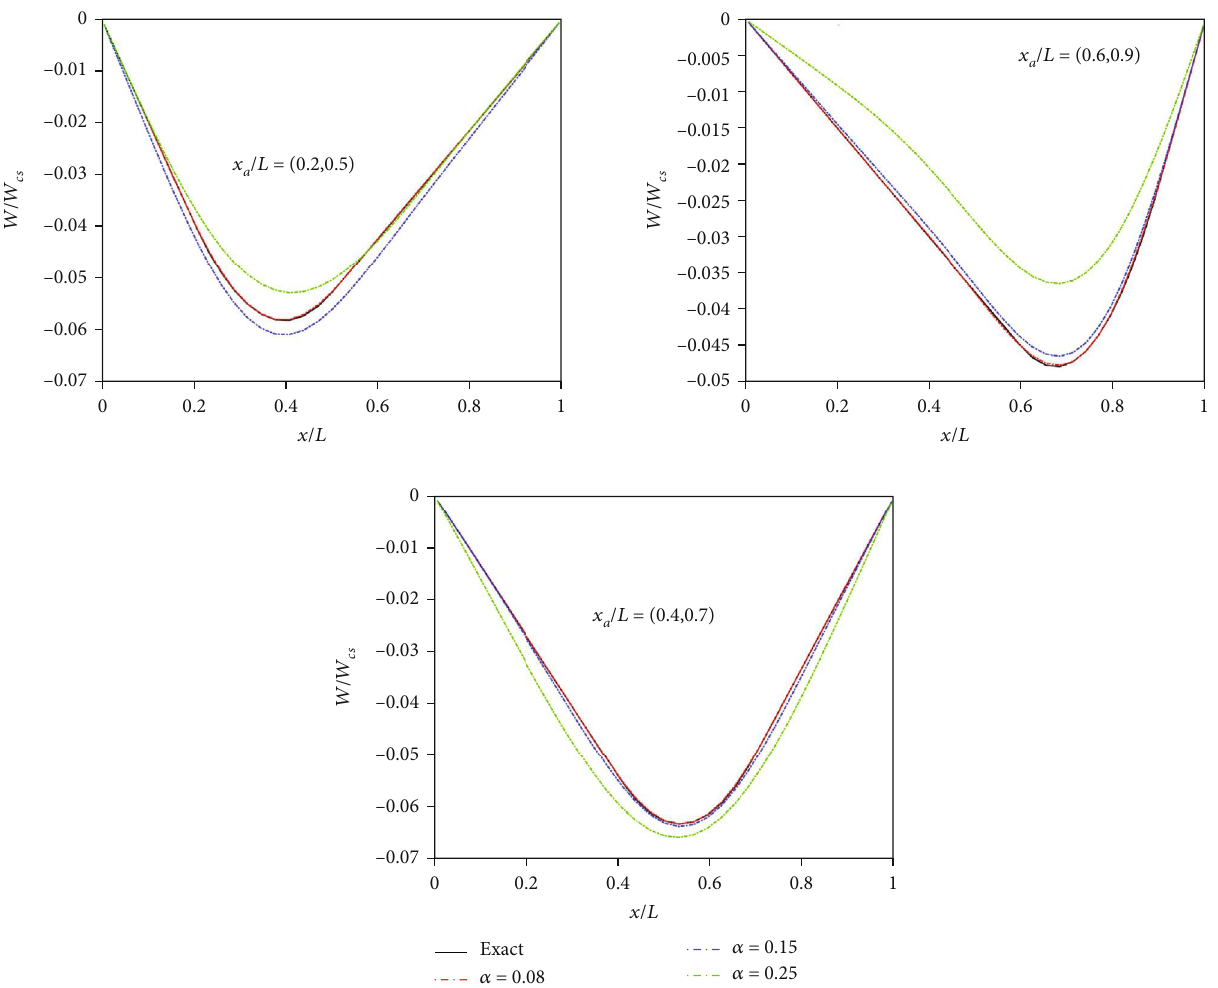
Figure 5: Convergence and accuracy of the numerical results with decreasing α of the dimensional de fl ection of a simply supported beam under a constant voltage V 0 applied by actuator for di ff erent locations ð n = 51 Þ